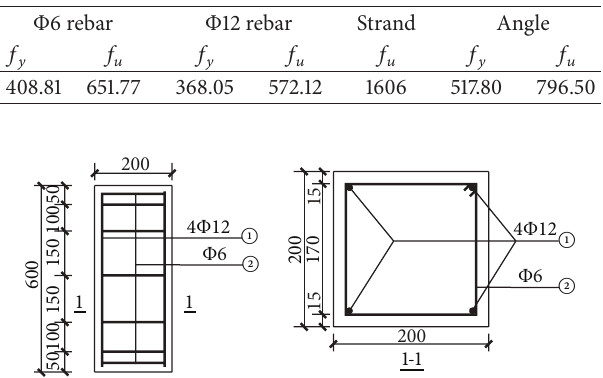
Figure 1: Dimensions and reinforcing bars of the columns (unit: